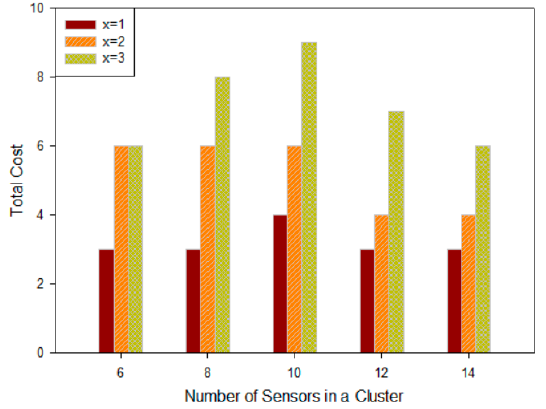
Figure 12. Relationship between number of sensors in a cluster and deployment cost.